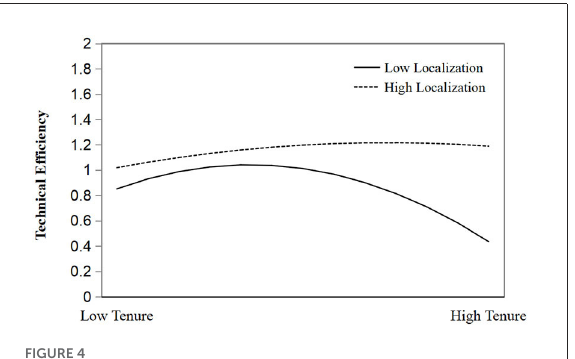
FIGURE4 The moderating effect of localization.